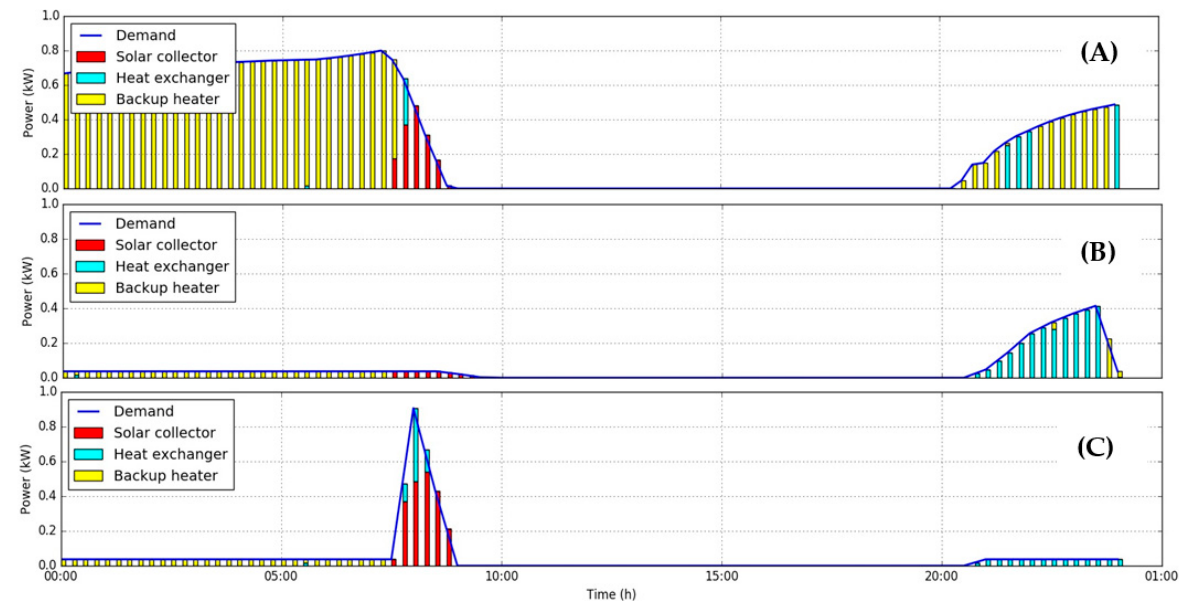
Figure 18. Demand profiles and sources of energy used to ensure comfort in ( A ) services, ( B ) domestic, and ( C ) office buildings [147].